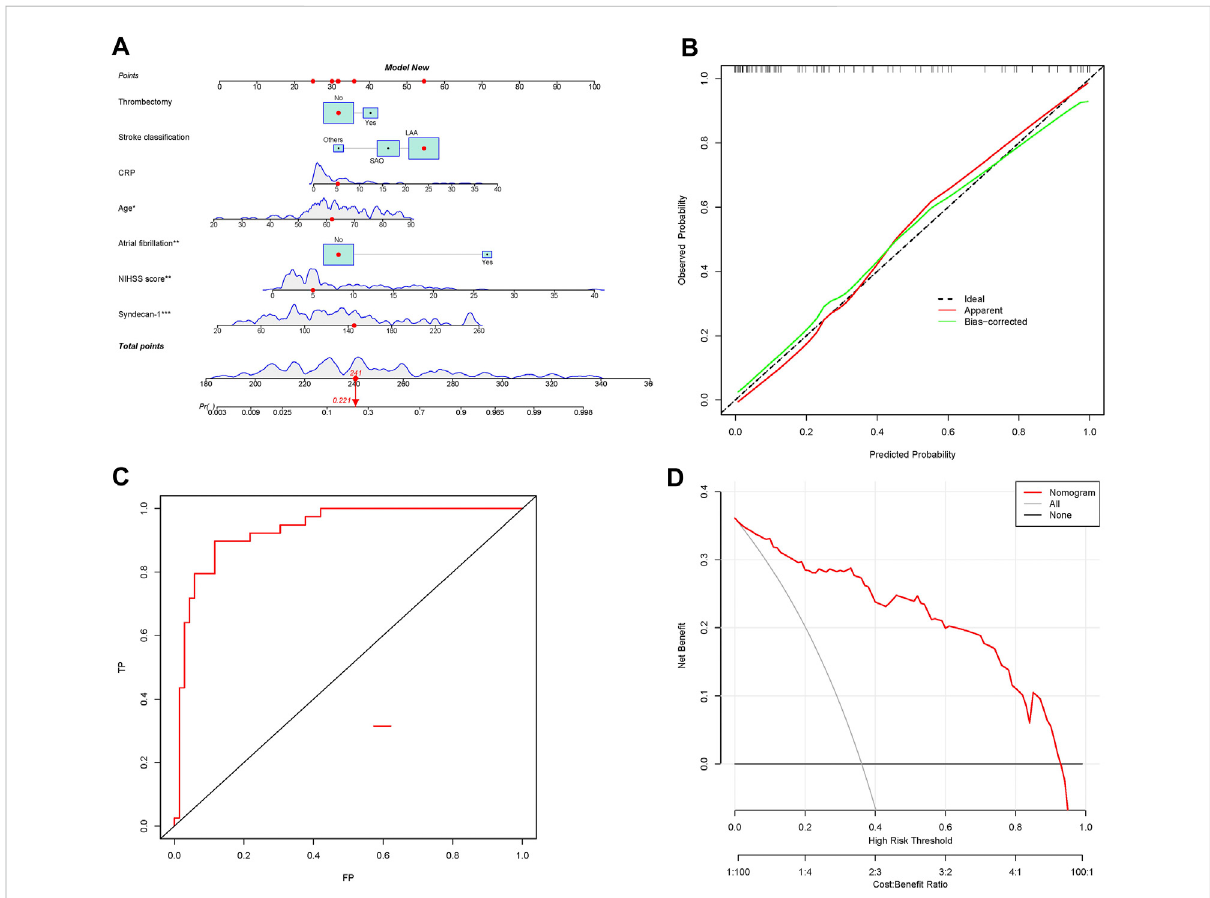
FIGURE 4 Nomograms for predicting prognosis using the risk model and evaluation of the prediction model. (A) Nomograms for predicting prognosis based on the risk model; (B) plots depicting the calibration of the risk model; (C) ROC plot based on nomograms for prognosis; (D) decision curve analysis of the model for predicting AIS prognosis following thrombolytic treatment. ROC, receiver operating